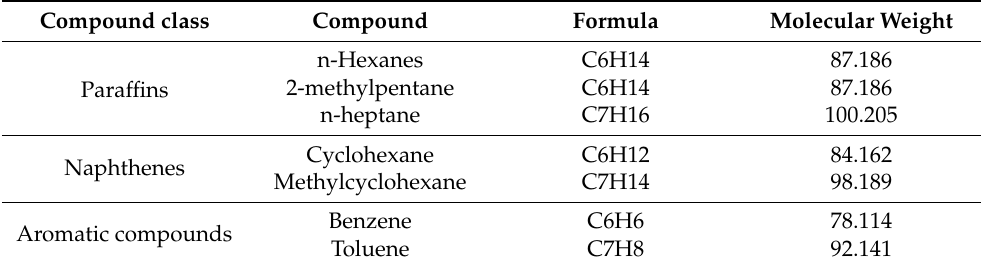
Table 3. Chemical composition of the oil used in this